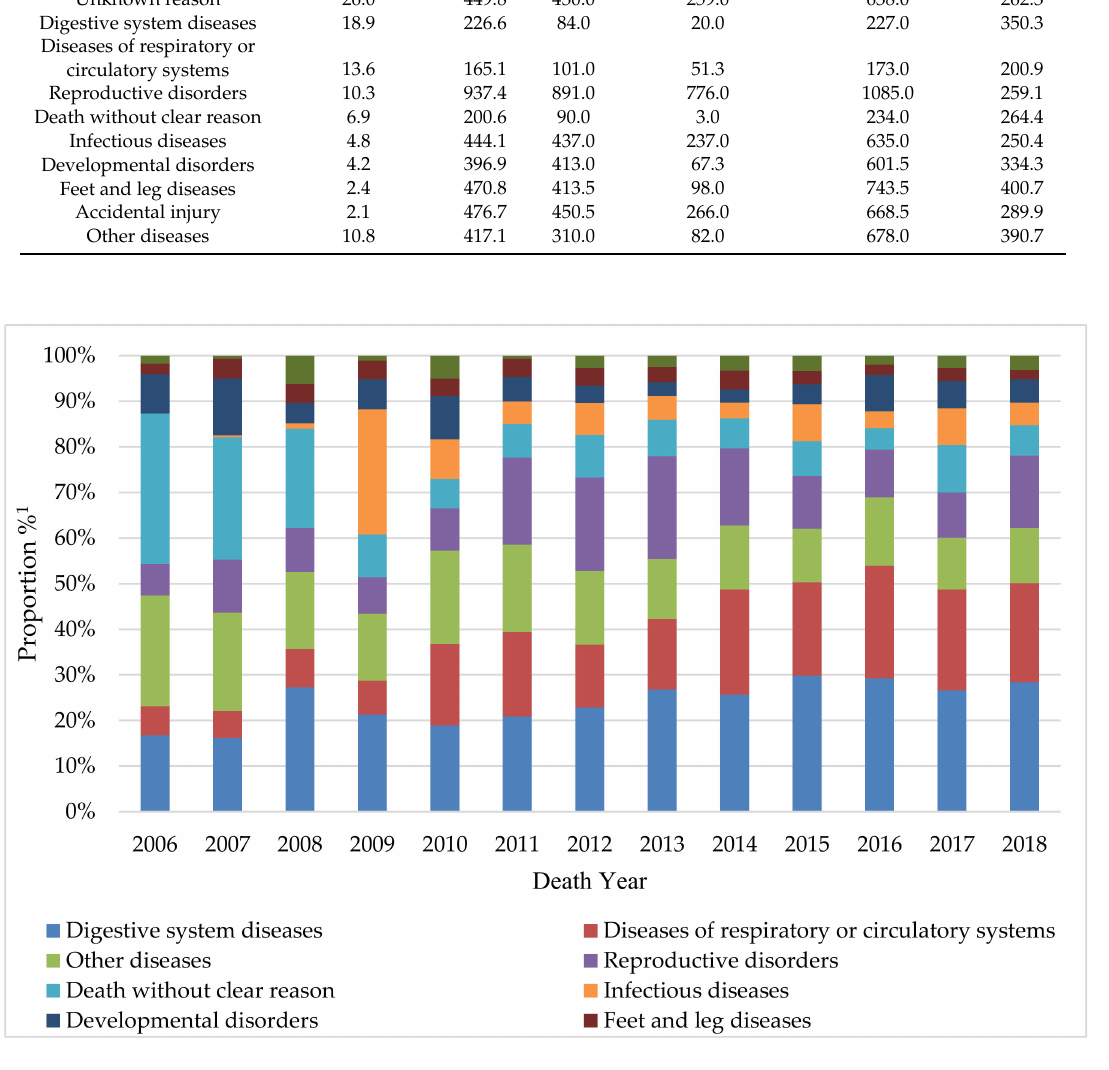
Figure 4. The death proportions of dairy calves and replacement heifers caused by di ff erent reason categories over time. 1 The category of “unknown reason” was not included in Figure